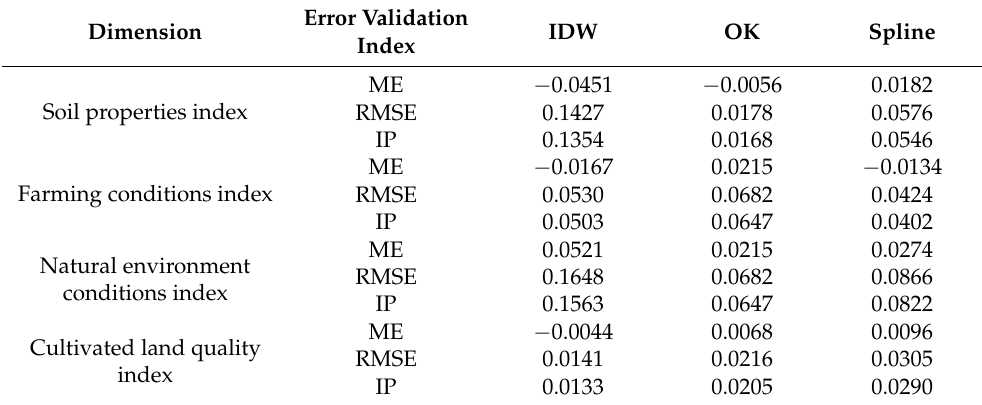
Figure 3. Cultivated land quality evaluation results of different scale cultivated land evaluation unit and spatial interpolation methods. ( a ) Cultivated land quality evaluation results based on small-scale cultivated land and the Inverse Distance Weight matrix method. ( b ) Cultivated land quality evaluation results based on large-scale cultivated land and the Inverse Distance Weight matrix method. ( c ) Cultivated land quality evaluation results based on small-scale cultivated land and the Ordinary Kriging method. ( d ) Cultivated land quality evaluation result based on large-scale cultivated land and the Ordinary Kriging method. ( e ) Cultivated land quality evaluation results based on small-scale cultivated land and the Spline Functions method. ( f ) Cultivated land quality evaluation results based on large-scale cultivated land and the Spline Functions method. Table 3. Cross-validation table of different spatial interpolation methods of three dimensions with large-scale cultivated